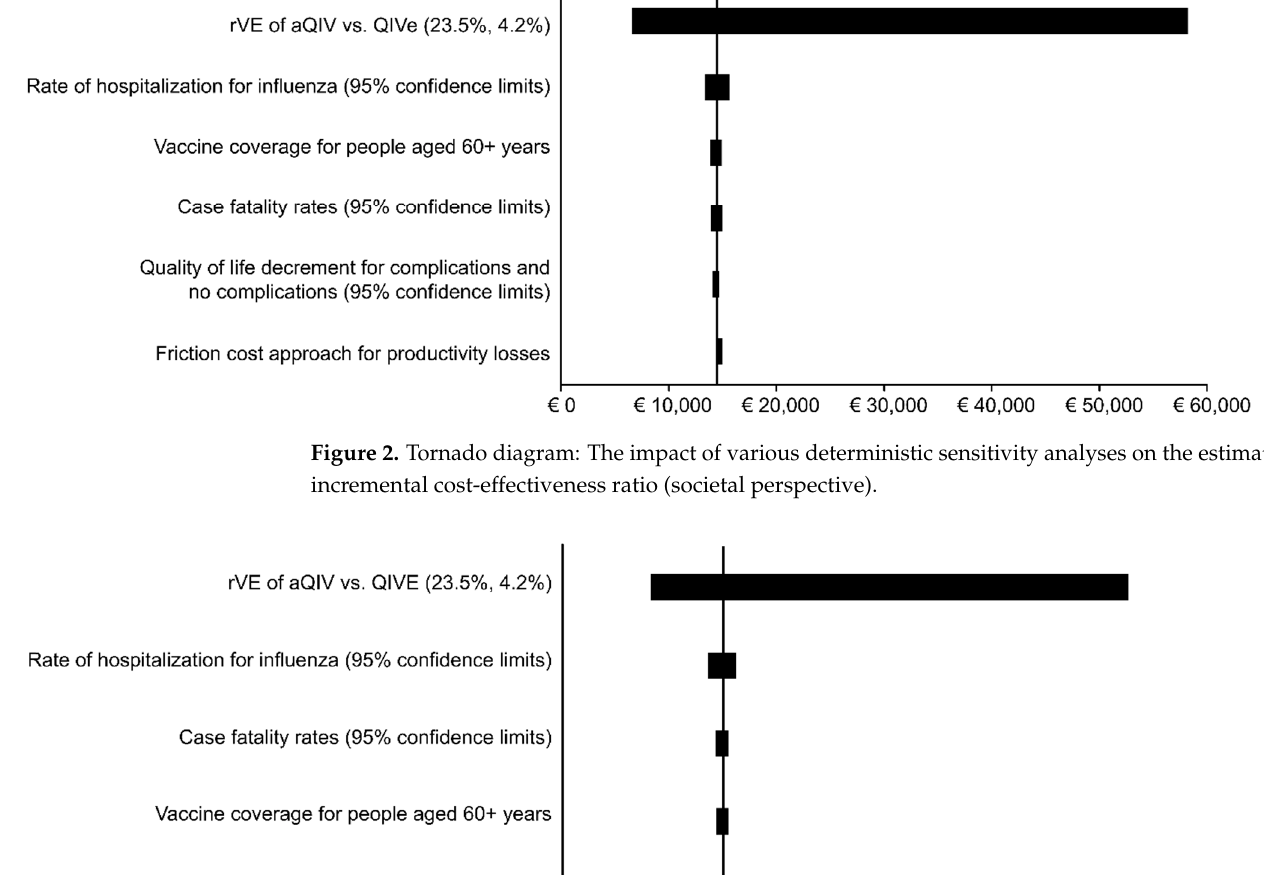
Table 6. Effectiveness scenario analyses: The impact of varying relative vaccine effectiveness on the cost-effectiveness of the enhanced vaccines (societal perspective).